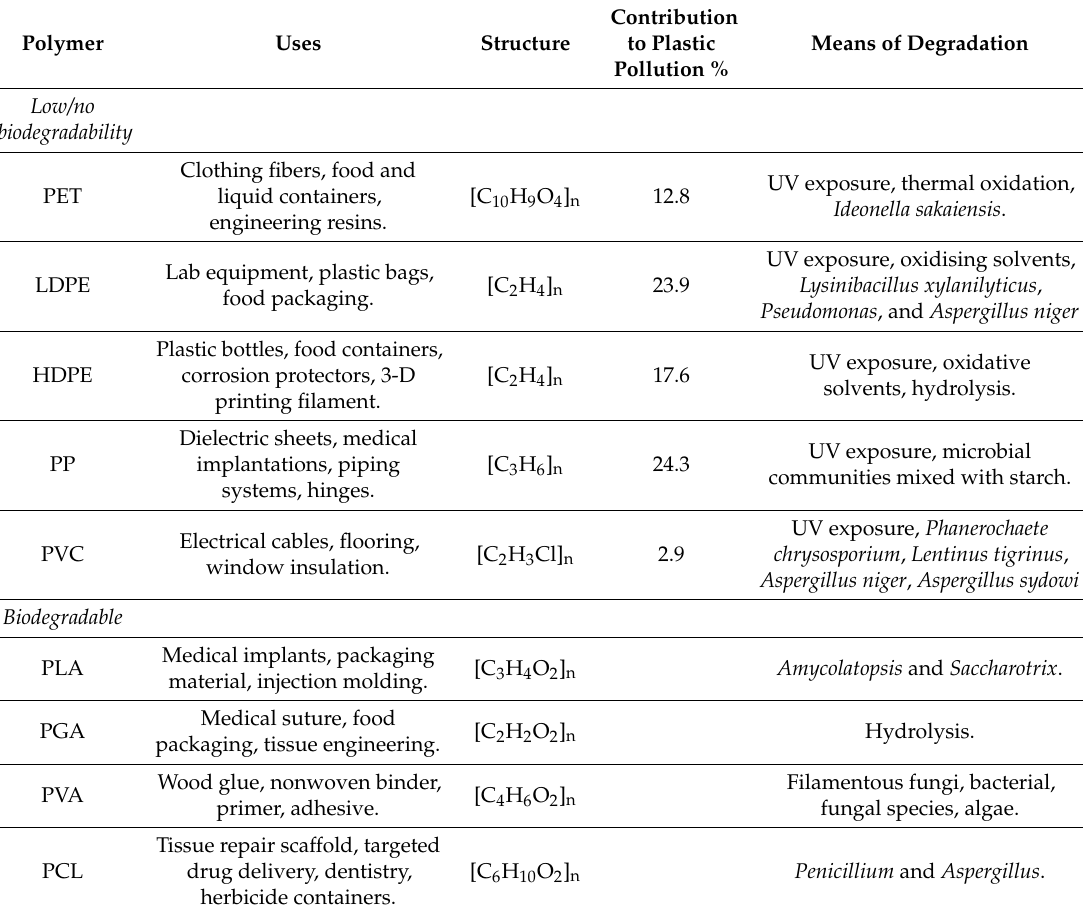
are more readily able to degrade through natural means